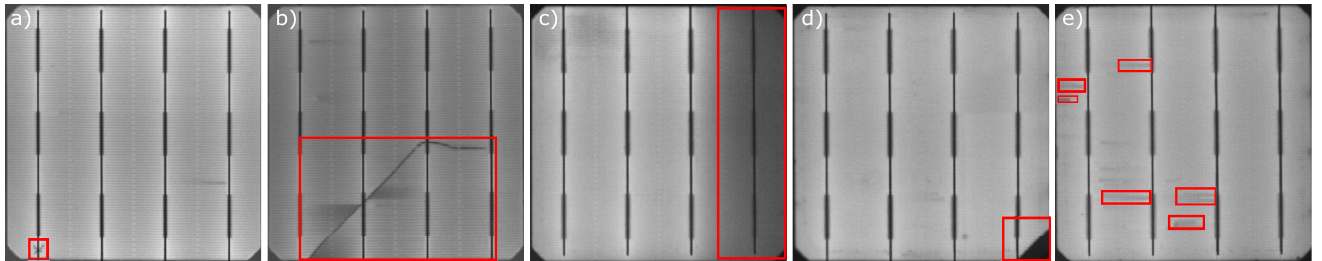
Figure 1. Different types of defects highlighted in Electroluminescence images. The defects are: ( a ) microcrack, ( b ) crack, ( c ) bad soldering, ( d ) break, and ( e ) finger